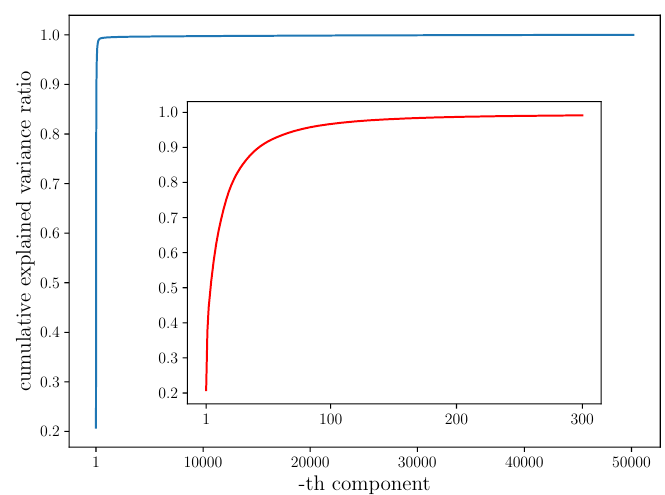
Figure 1. CEVR R i obtained by using SVD. The blue line shows for all components in the training set, while the red one only shows for 1 ≤ i ≤